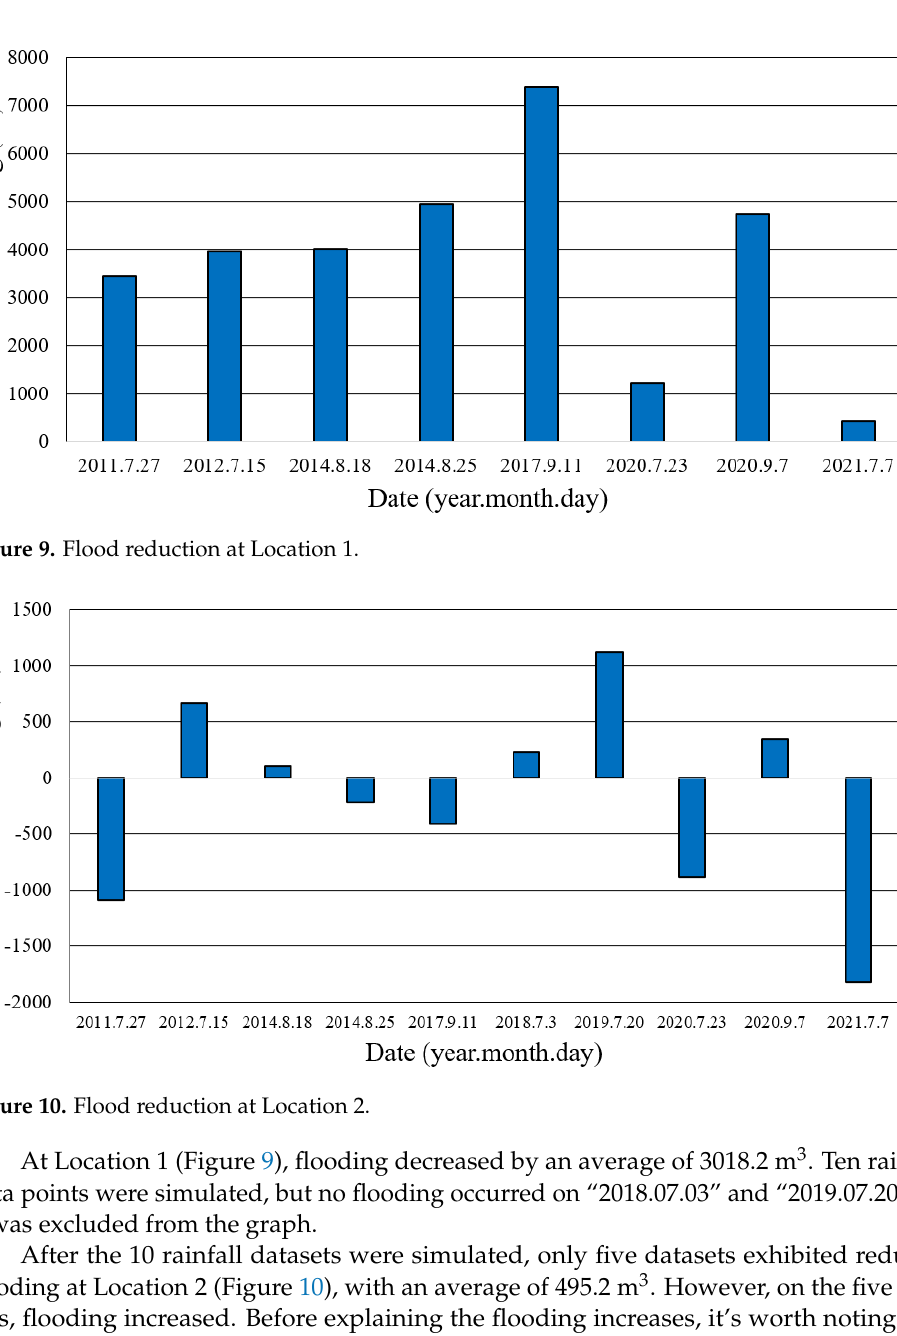
Figure 9. Flood reduction at Location 1.